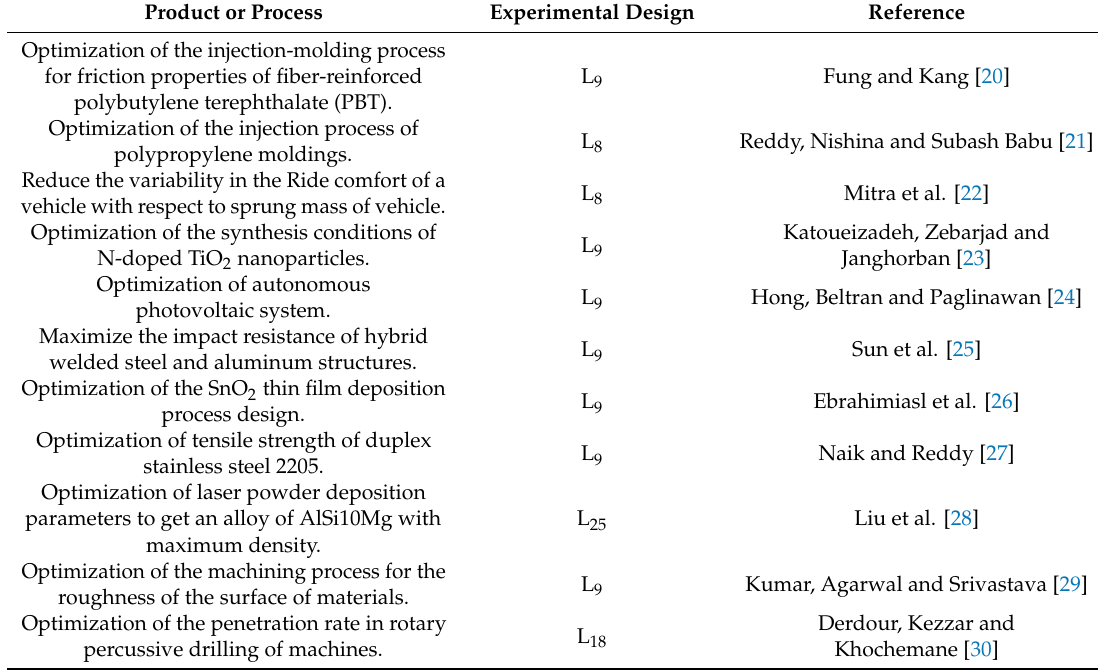
Table 1. Examples of applications using the Taguchi methodology in di ff erent products or processes in the field of engineering.